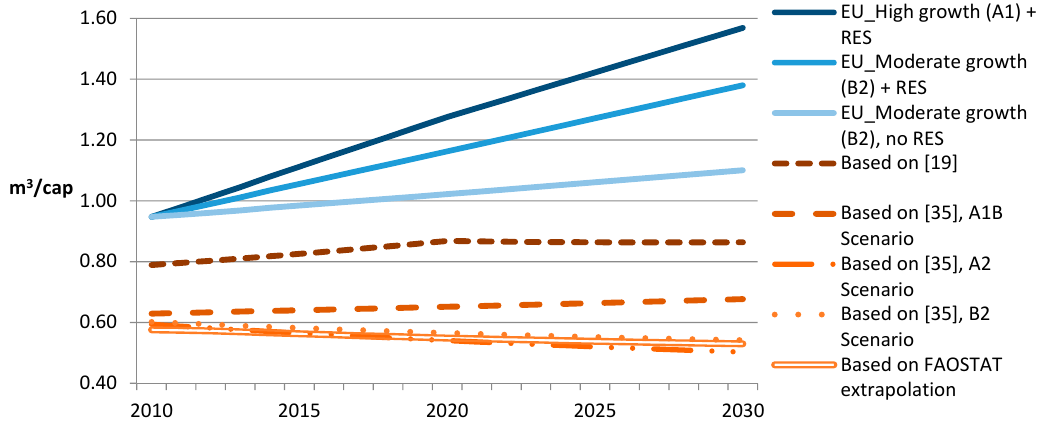
Figure 3. Scenarios of global and EU per capita consumption of primary timber under different sources [18,19,35,39].